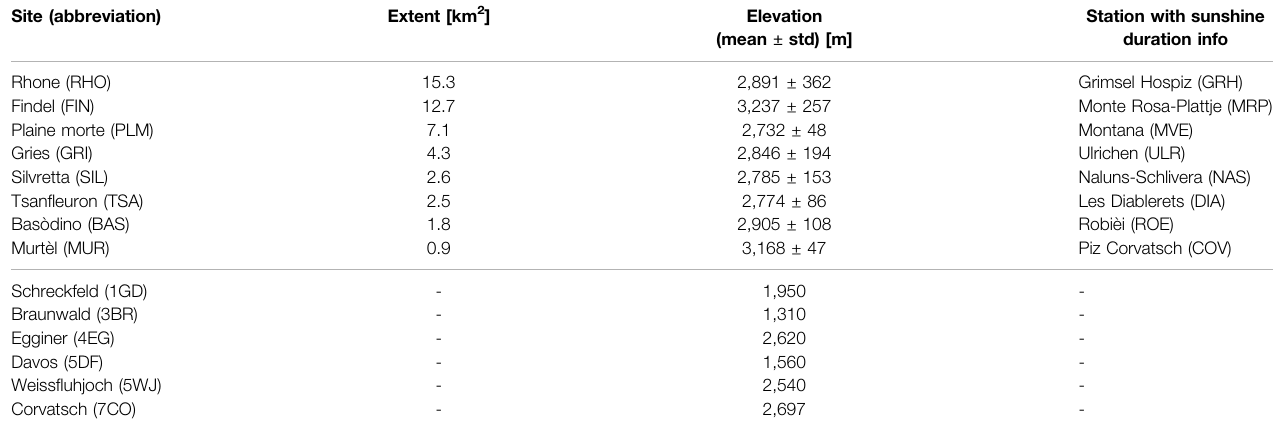
TABLE 1 | Description of the glacier and non-glacierized